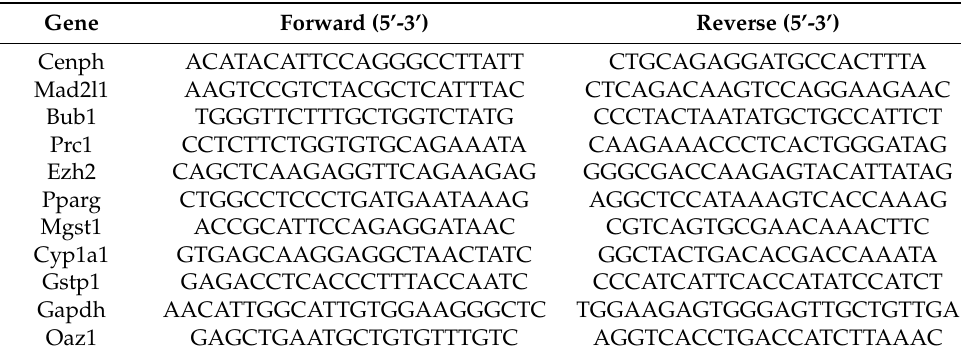
Table 1. List of qRT-PCR primers used in this study.